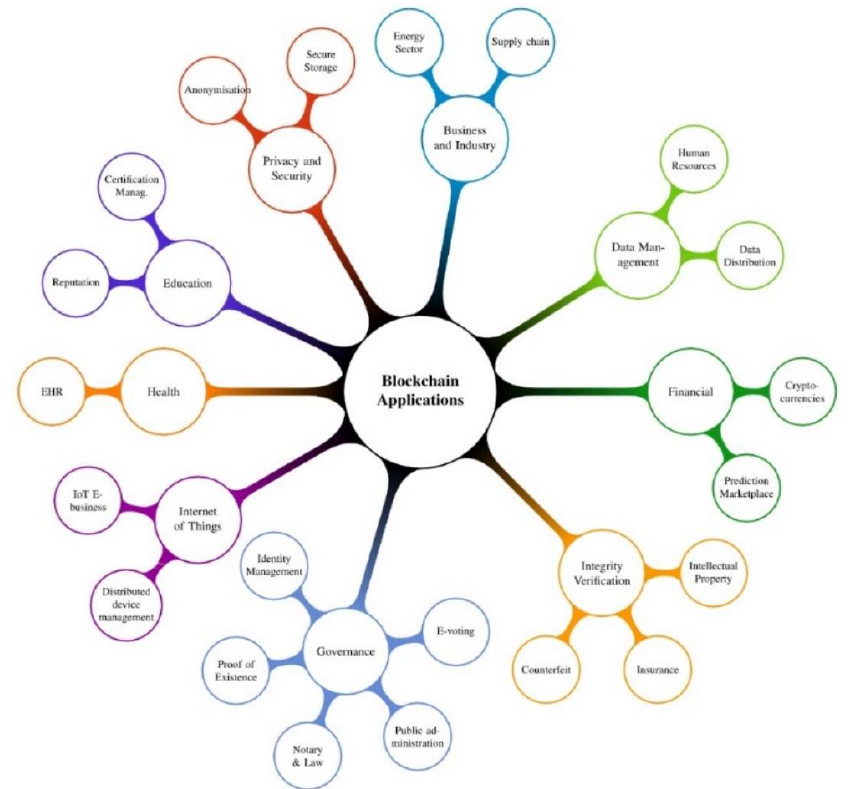
Figure 1. Mindmap abstraction of different types of blockchain applications. Source: Casino,